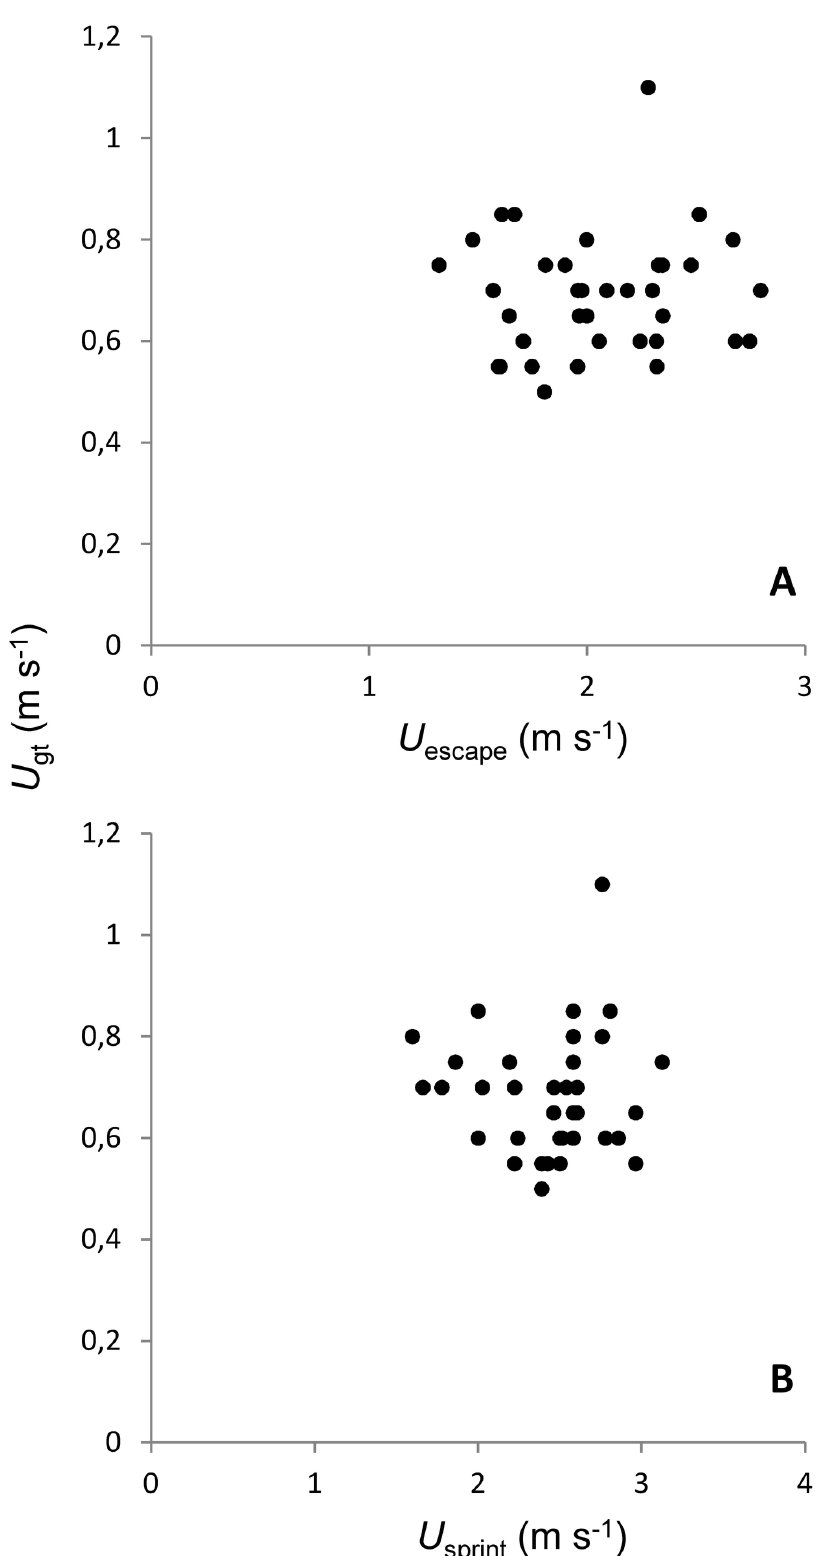
Figure 2. Relationship between (A) U